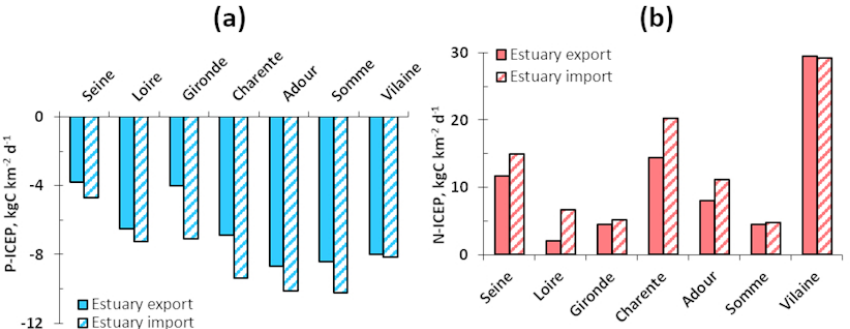
Figure 8. Indicator of coastal eutrophication potential (ICEP) for the estuaries studied. Panel (a) shows P-ICEP and panel (b) shows